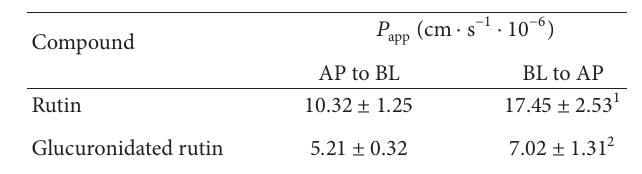
) of polyphenol app